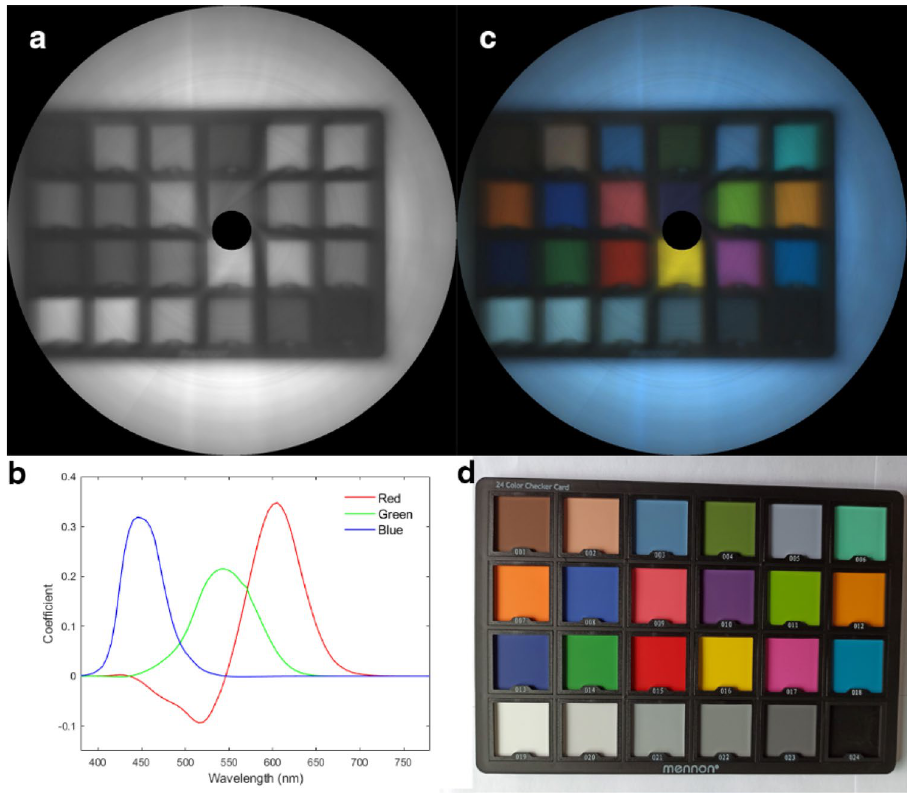
Figure 6. ( a ) Full spectral image; ( b ) CIE-1931 RGB stimulation coefficient; ( c ) color restoration; ( d ) color